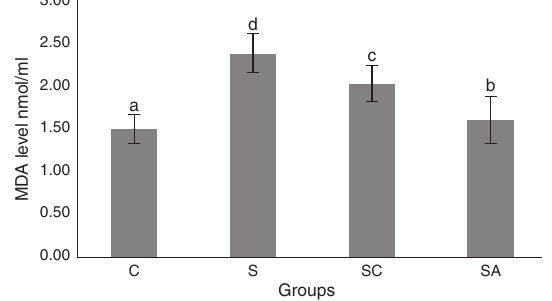
Figure 4 Malondialdehyde (MDA) levels of the study groups. All groups showed a statistical difference from each other. Group S presented the highest MDA level. C, control group; S, sinusitis group; SC, sinusitis + cefazolin group; SA, sinus- itis + amlodipine group. Used the analysis of variance (ANOVA) and LSD tests and were considered to be significant at p < 0.05 (all groups). The bars in the different serial shown by the differ- ent letters (a, b, c, and d) are statistically different from each